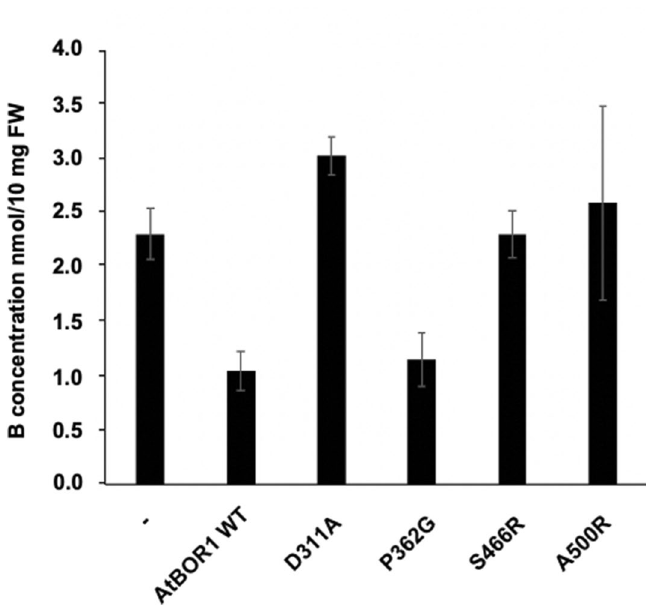
Figure 4. Borate efflux activity of the AtBOR1 variants in yeast. FGY217 Δ bor1p cells expressing each of the AtBOR1 proteins were assessed for their ability to export boron relative to control cells transformed with vector only. − = vector only control. Intracellular B content (nmol/10 mg FW) after 60 min incubation of cells in 1 mM boric acid. Values have been normalised to GFP concentration. Data shown is mean ± S.D. of n = 3 independent experiments.